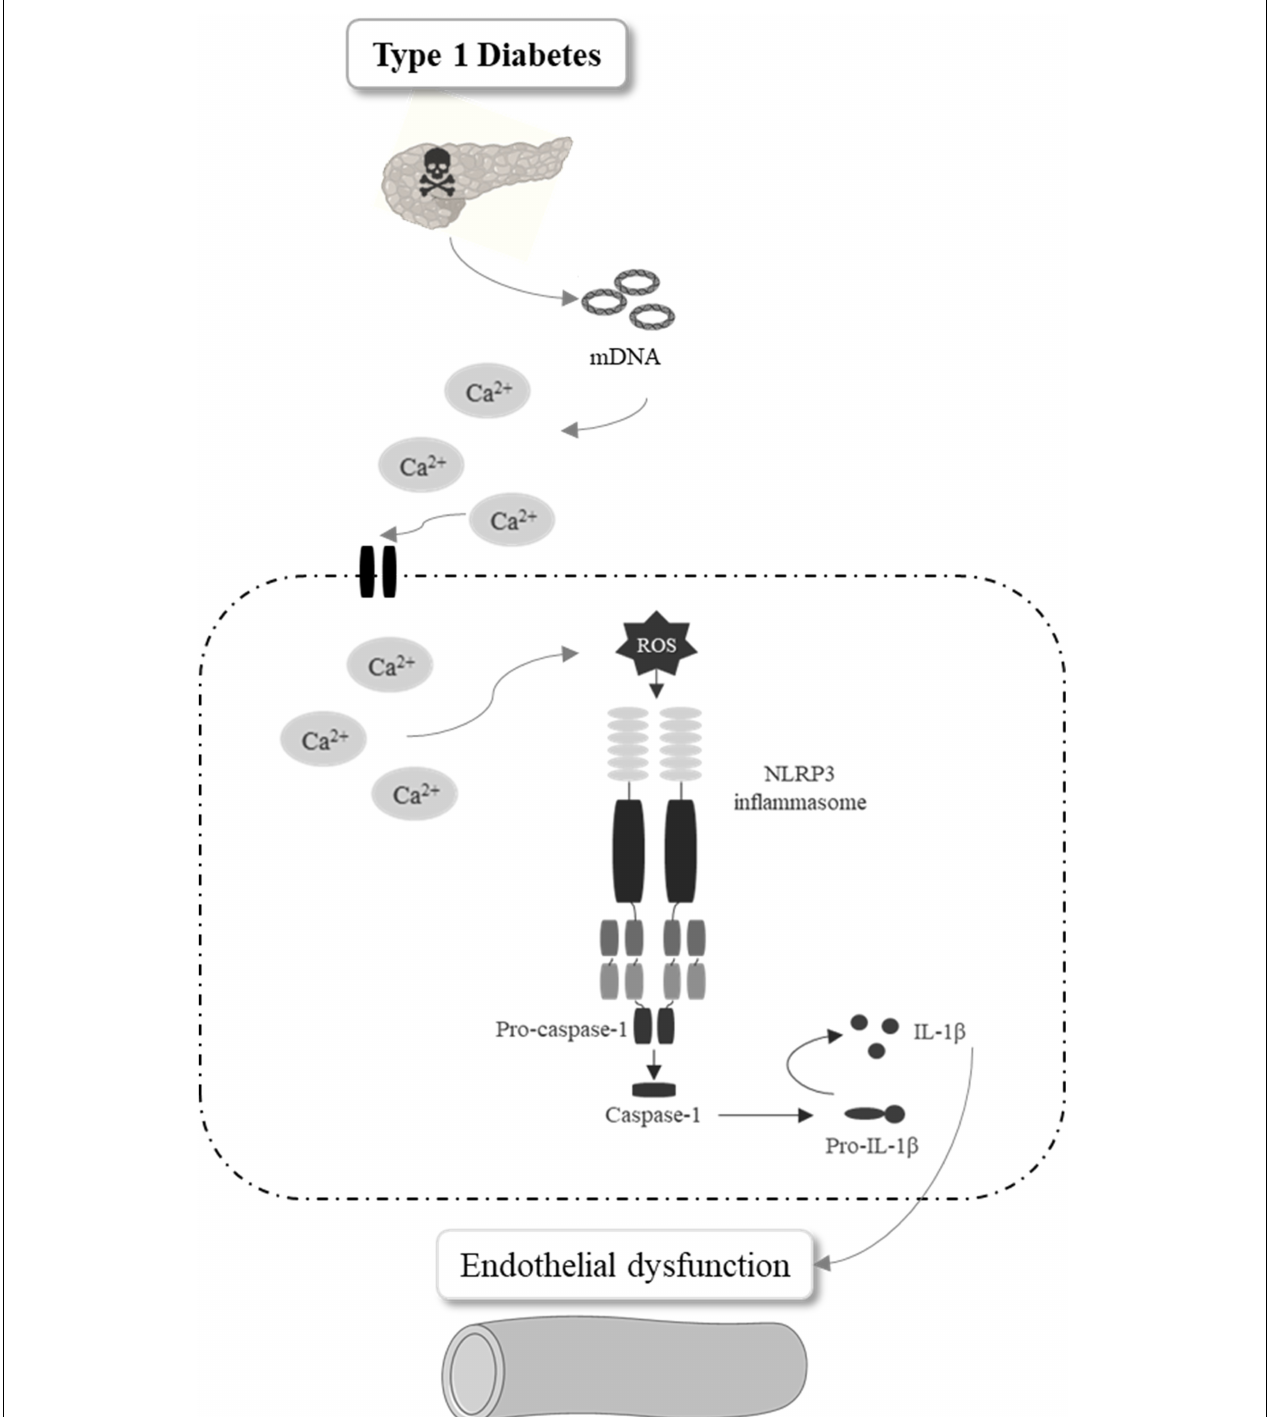
FIGURE 8 | Schematic representation of the conclusion. Pancreatic mitochondrial DNA release in type 1 diabetes increases Ca 2 + influx and mitochondrial ROS generation in endothelial cells promoting caspase-1 and IL-1 secretion by NLRP3 inflammasome activation, events that contribute to diabetes-associated endothelial